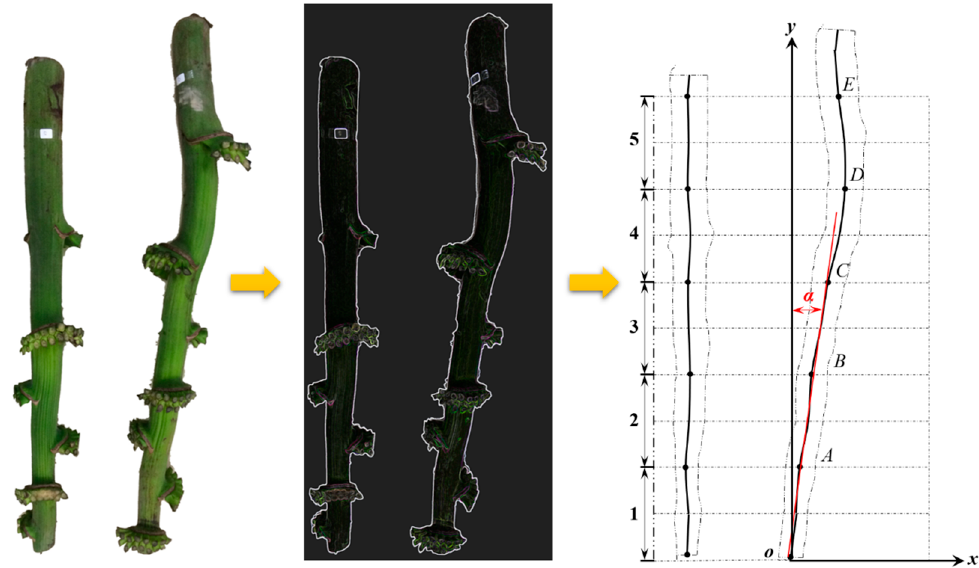
Figure 3. Schematic diagram of measurement of the curvature of banana bunch stalk.